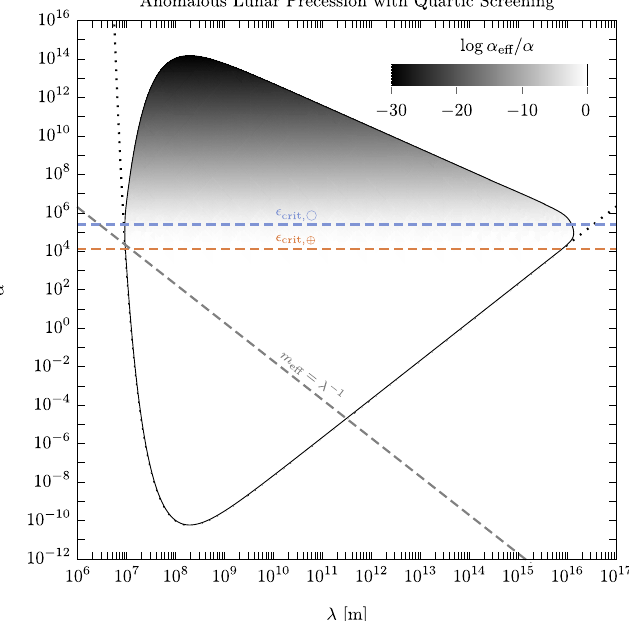
Figure 3 . Anomalous lunar precession bound on ’ -mediated (cid:12)fth force in the plane of coupling strength (cid:11) and range (cid:21) including the e(cid:11)ects of a natural quartic self-interaction (cid:15) 9 (cid:11) 2 . The area inside of the black contour is excluded by the existing bound on the anomalous precession of the Moon. The lower edge of the exclusion matches the un-screened case (dotted black line). As one goes up in (cid:11) , the natural quartic becomes large enough to begin to screen the e(cid:11)ective charges of the Earth and then the Moon (lower and upper horizontal dashed lines, respectively). The reduction of the e(cid:11)ective coupling (cid:11) e(cid:11) due to screening is shown by the density plot, with darker colors corresponding to largest screening/smallest (cid:11) e(cid:11) . Above the gray diagonal dashed line the contribution of the quartic term in the potential to the ’ mass in Earth is larger than the vacuum mass (cid:21) (cid:1) 1